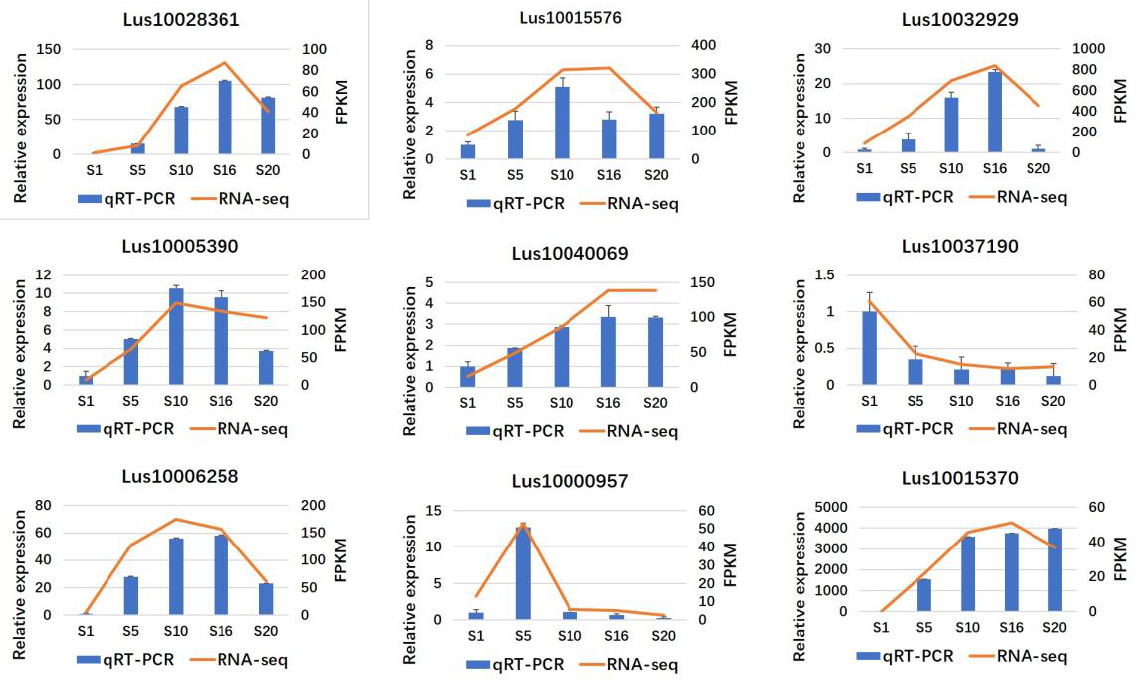
Figure 6. Validation of RNA-seq data by qRT-PCR. Flax stems of fast-growing stage were divided into 20 equal parts that were named S1 – S20. S1 is closest to the shoot apex, and S20 is closest to the root. Five parts were selected for the qRT-PCR verification. Each gene was normalized with S1 as the control.